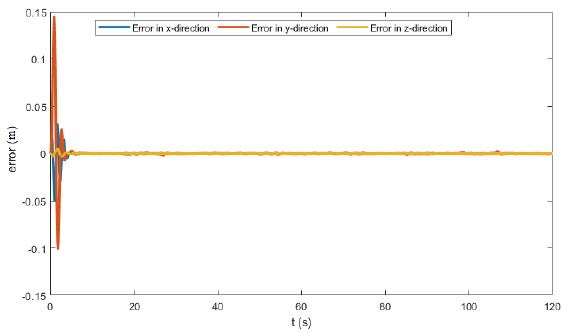
Figure 20. The position error profile for terrain 1.